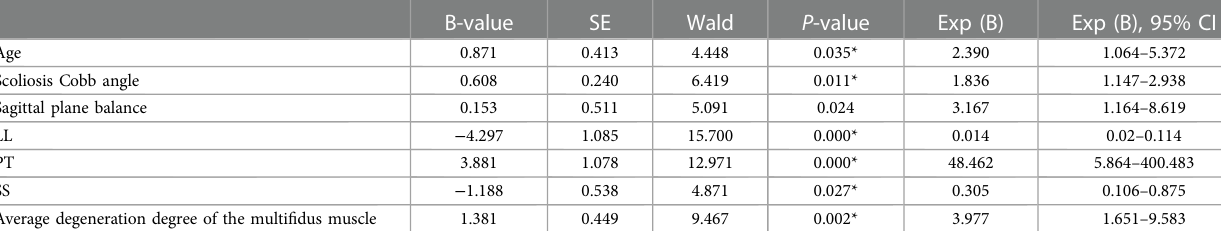
TABLE 6 Univariate logistic regression analysis of signi fi cantly different variables for the factors associated with PI-LL mismatch.